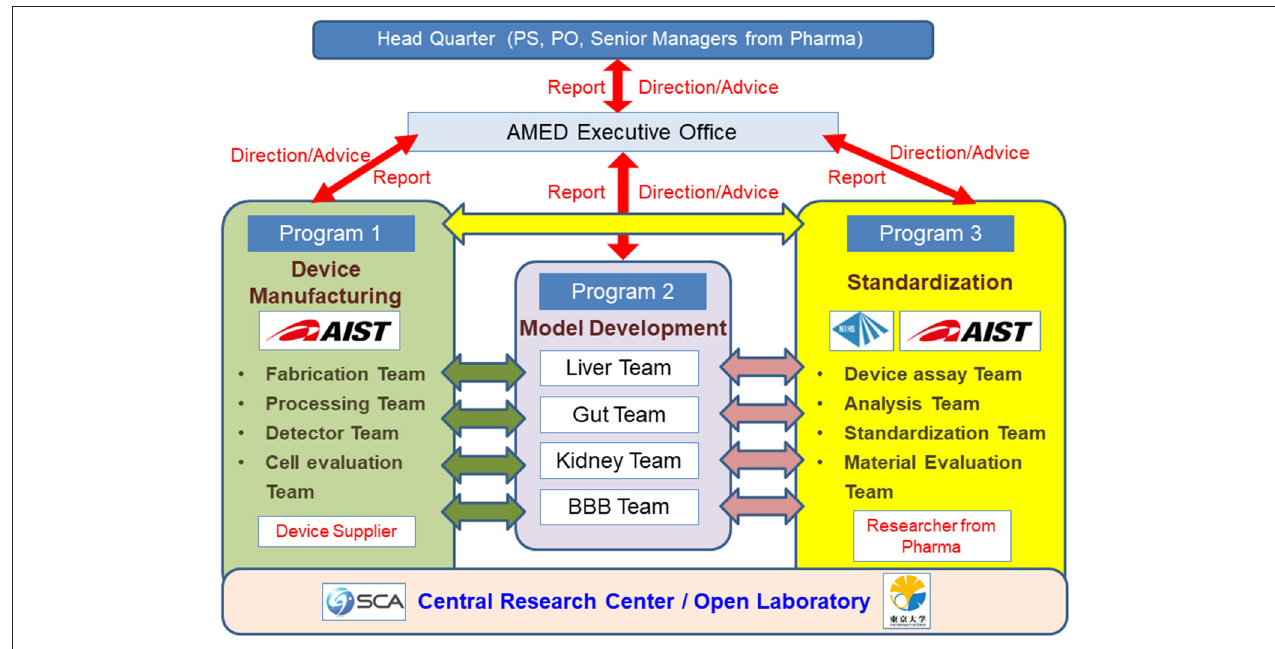
FIGURE 1 | Research and Development Organization of the AMED-MPS Project. Researchers from the National Institute of Advanced Industrial Science and Technology (AIST) and the National Institute of Health Sciences (NIHS) coordinate the manufacturing (Program 1), performance evaluation, and standardization (Program 3) of MPS developed by universities and other academic institutions (Program 3). Device suppliers (Program 1) and pharmaceutical companies (Program 3) equally participate in this project. The target organs/tissues are the liver, small intestines, kidneys, and blood-brain barrier.